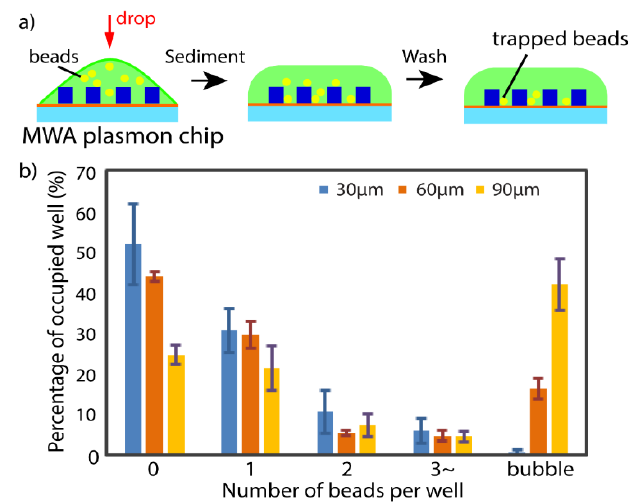
Figure 4. Optimization of 15 µ m beads trapping over various thickness range: ( a ) About 150 µ L of beads solution was dispersed on MWA plasmon chip before washing after 30 min; ( b ) beads trapping capability of varies thickness range of 30 µ m, 60 µ m, and 90 µ m (error bar represents standard deviation with n = 3).